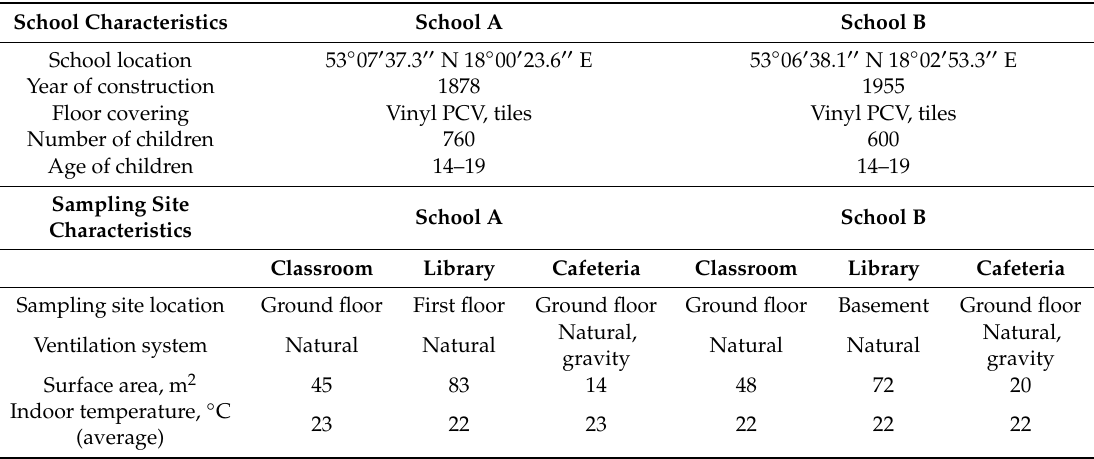
Table 1. Description of sampling